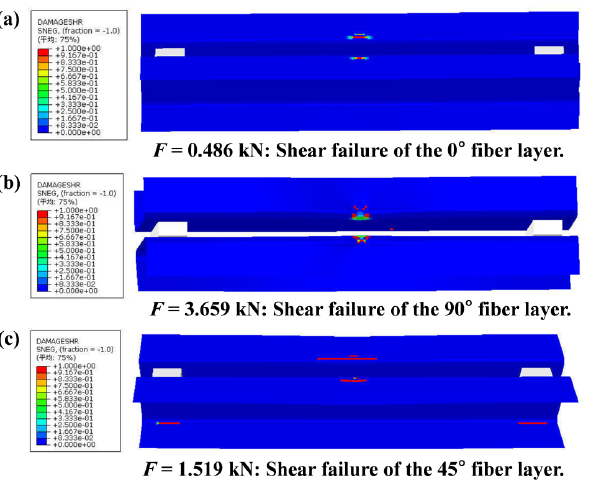
Figure 24: Shear failure area distribution of fiber layers in ultimate bearing state: (a) SHCXL-A: 0 ∘ fiber layer; (b) SHCXL-A: 90 ∘ fiber layer; and (c) SHCXL-B: 45 ∘ fiber layer.